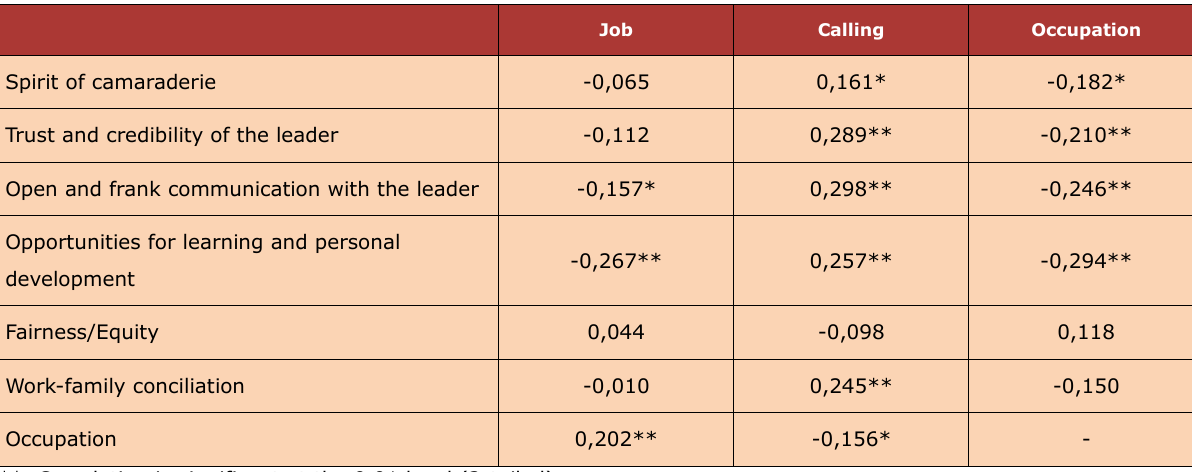
Table 6. Pearson’s